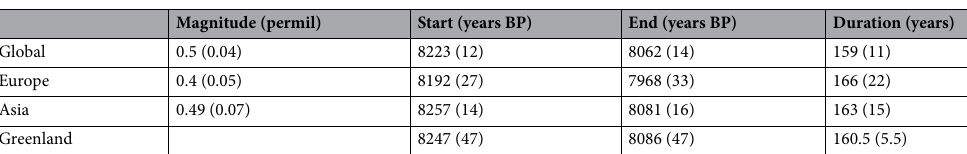
Table 1. Median start, end and duration of the 8.2 ka event registered in speleothem records, globally and for the Europe/Mediterranean and Asia regions. Standard error associated with each value is given in brackets. For all variables, regional values are insignificant from one another, according to a t test (at P < 0.01). Timing and duration of the 8.2 ka event in Greenland ice core are also shown, with their uncertainty 9,12